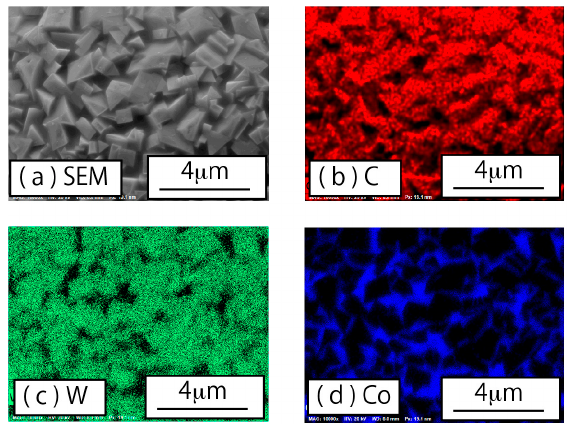
Figure 6. High-magnification SEM images of WC–Co particle surfaces of ( a ) raw powder and ( b ) plasma-treated powder.